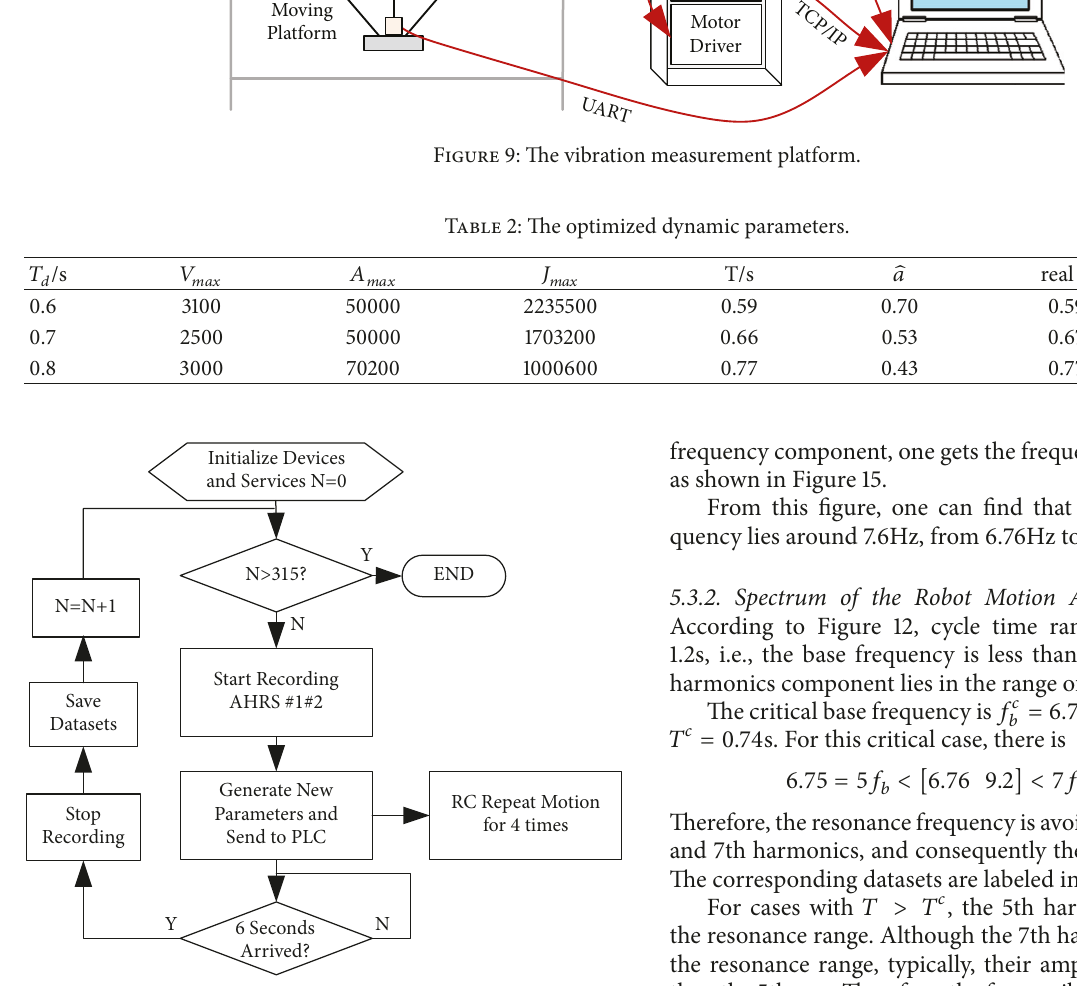
Figure 10: Flowchart of the vibration signal acquisition